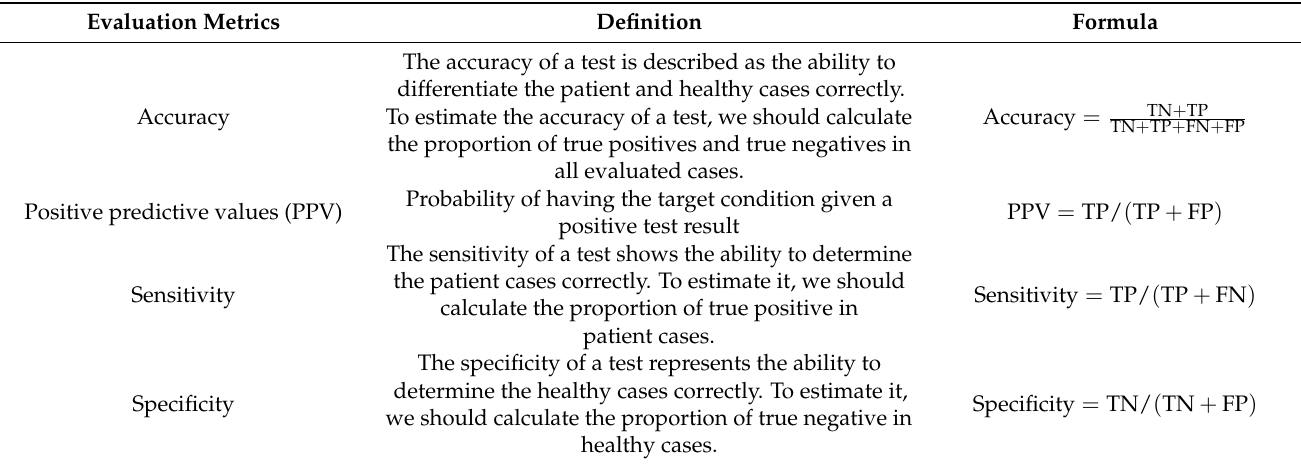
Table 2. Performance evaluation